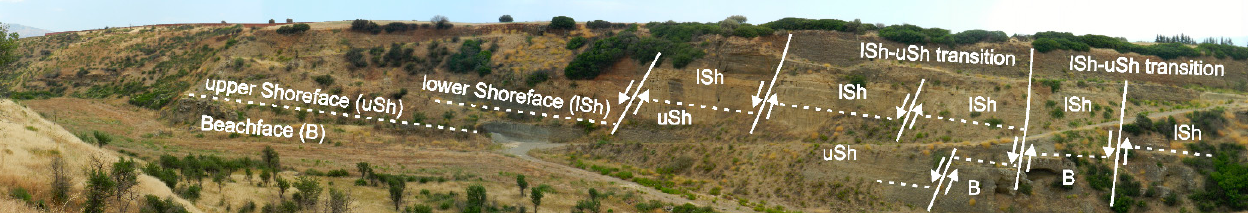
Figure 9. T3 terrace shallow-marine conglomerates and sandstones (FA2). The contact between beachface gravels and shoreface sandstones and conglomerates is displaced by a synsedimentary NE-SW-trending normal fault responsible for the NE-directed increase in fault-controlled subsidence and thickening of terraced succession. B: Beachface; uSH: upper Shoreface; lSH: lower Shoreface.